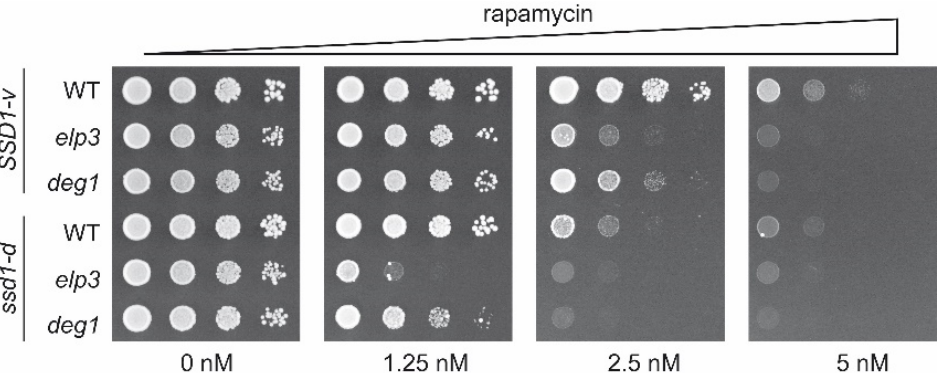
Figure 2. Comparison of the rapamycin sensitivity of tRNA modification mutants in SSD1-v and ssd1-d backgrounds. WT, elp3 , and deg1 mutants of both background strains were serially diluted and spotted on YPD plates containing the indicated amounts of rapamycin. Plates were incubated at 30 °C for 48 h.